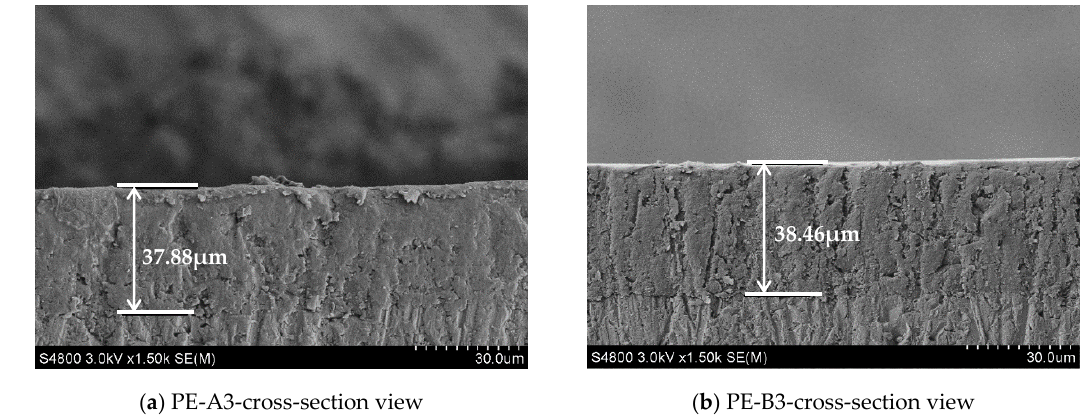
Figure 15. SEM micrographs of coating films with the addition of Al(OH) 3 and BaSO 4 respectively.